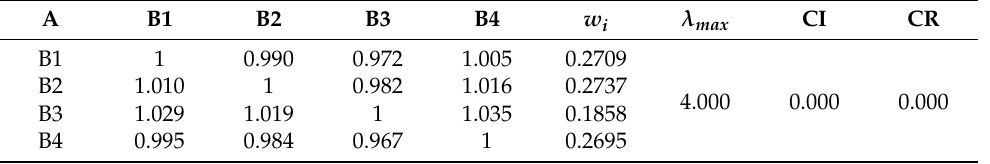
Table 6. Target layer judgment matrix and weight value of influencing